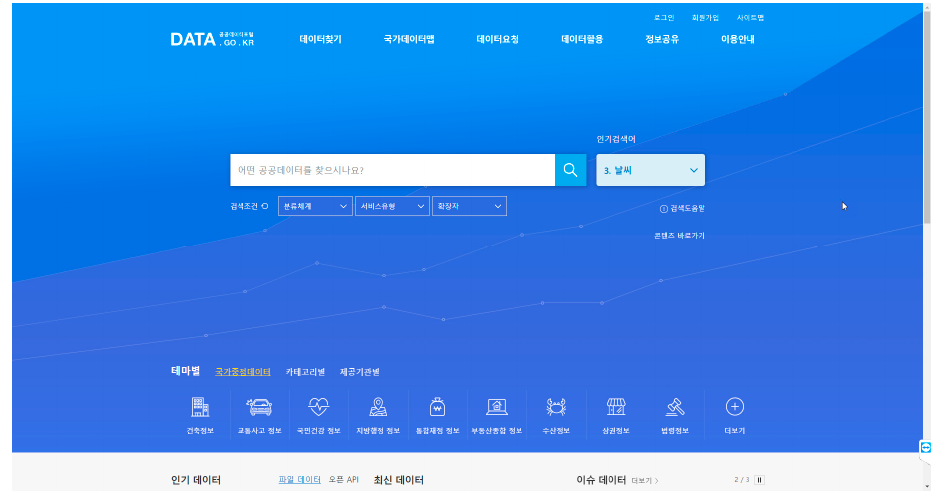
Figure 19. Korea Public Data Portal (Source: data.go.kr (accessed on 24 July 2020)).